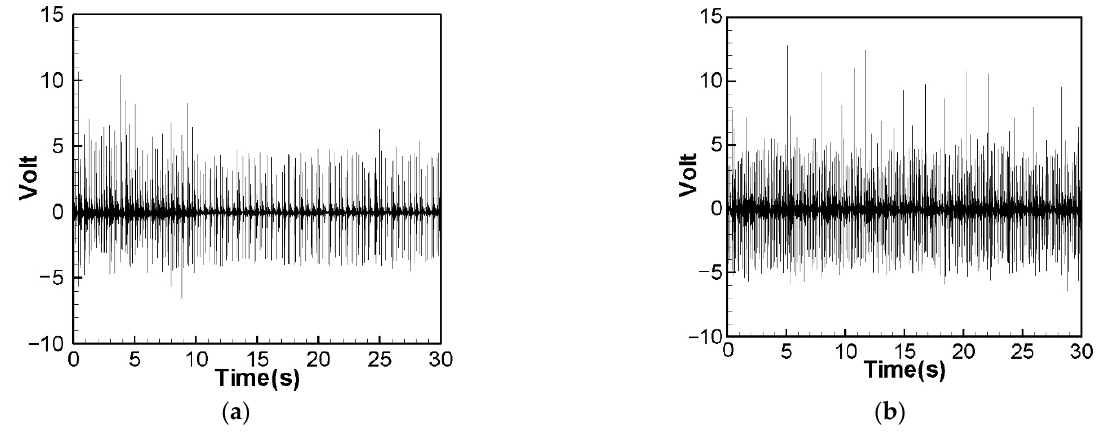
Figure 11. Experimental voltage output for nonlinear frequency excitation (elastic steel 5 cm). ( a ) 1st mode, ( b ) 2nd mode.